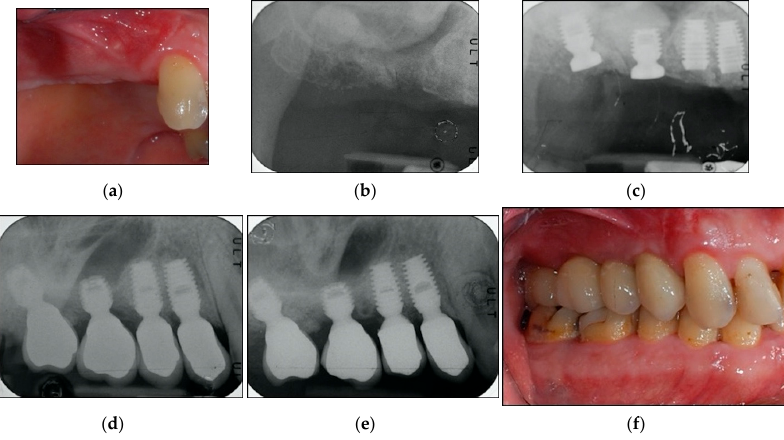
Figure 3 . ( a – f ). Clinical case: Four implants placed in 1.4, 1.5, 1.6, and 1.7 sites. ( a ) Clinical photograph before implants placement. ( b ) Pre-operative radiograph before implants placement in sites 1.4, 1.5, 1.6, and 1.7. See minimal bone levels. ( c ) Radiograph obtained at time of implants placement. Two of the implants have sinus lift abutments. Augmented sinus visible. ( d ) Implants restored. Radiograph obtained at time of loading. ( e ) Radiograph obtained at the three-year follow-up. See stable bone levels both for sites with augmented sinus floor and for sites without it. ( f ) Clinical photograph at three-year follow-up. See stable clinical